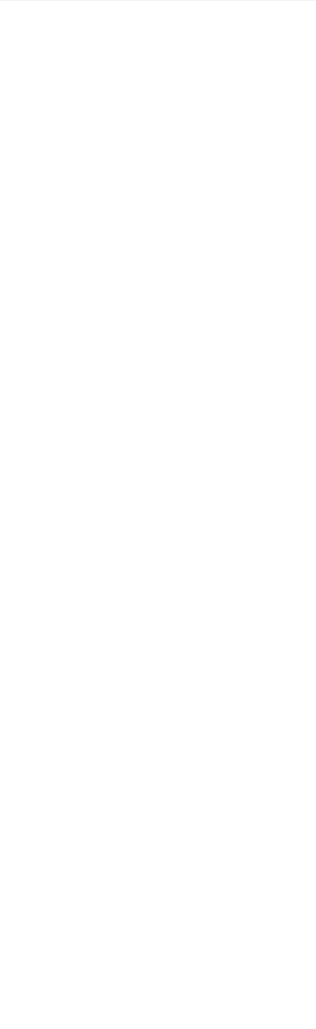
FIGURE 3 LOD graph of the QTL qPsBr2.1 in LG2 detected for the percentage of damaged seeds caused by C chinensis and C maculatus in the F 2 population F2Y grown in Youyu (A) and in the F 2 population F2N grown in Nanjing (B) . The F 2 populations are derived from a cross between PWY19 and